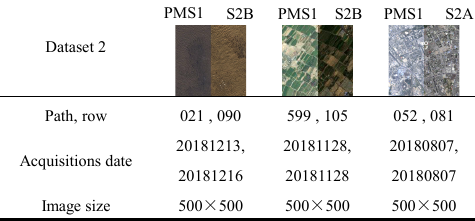
Table 3. GF-1 PMS and Sentinel-2 MSI study areas